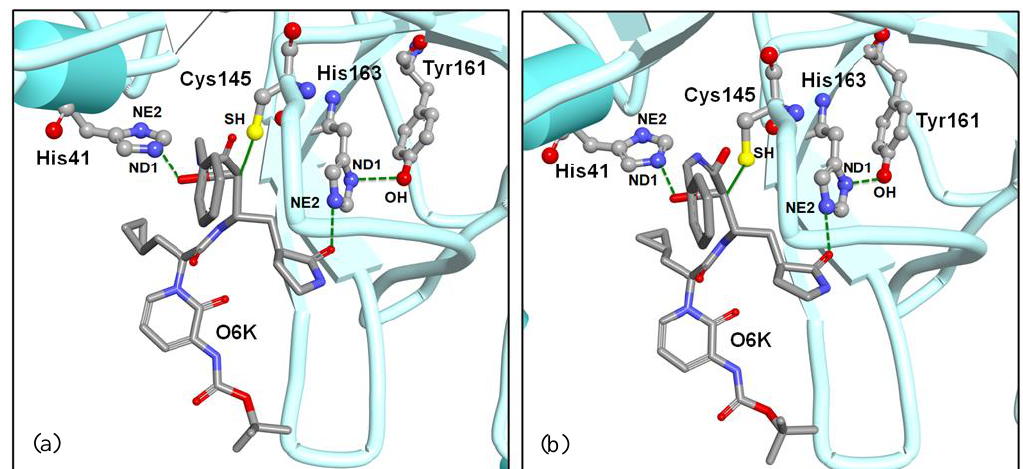
Figure 5. The ligand (O6K) α-ketoamide is covalently bonded with SG of Cys145 and is also H-bonded with ND1 of His163 and NE2 of His41. The left panel (a) and right panel (b) reveal the interactions of O6K with catalytic residues His163, Cys145, and His41 in 6Y2F and 6Y2G crystal structures respectively.